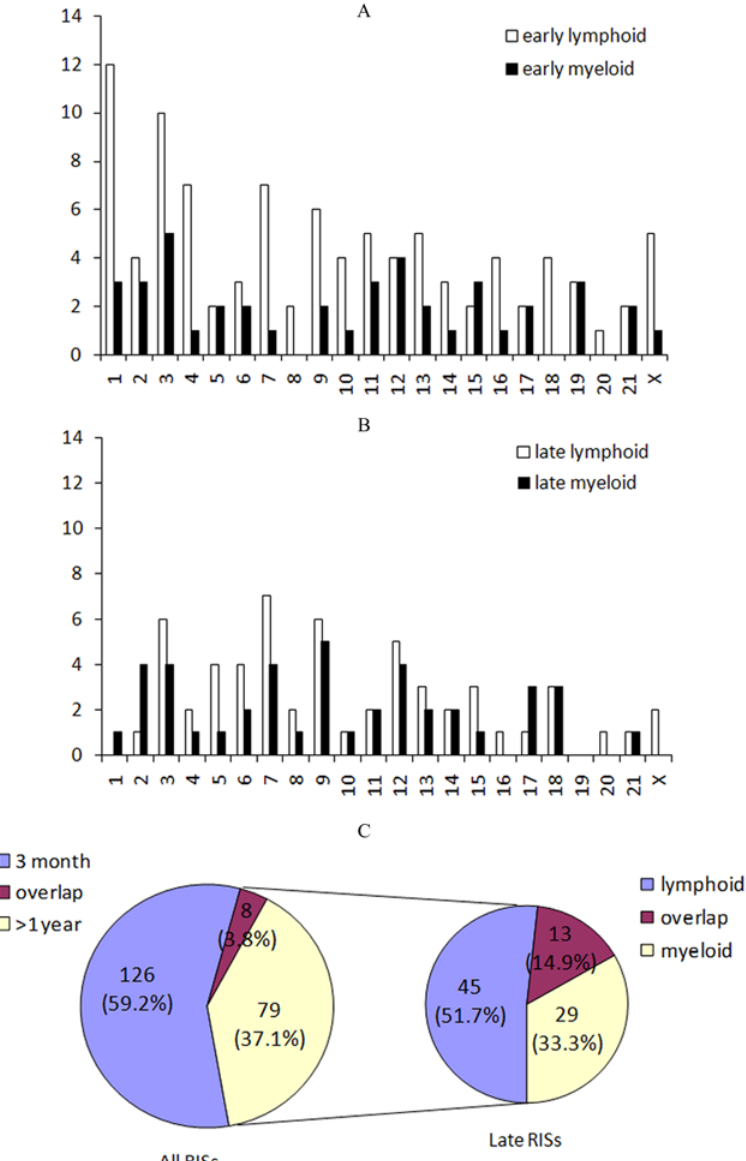
Figure 2. Distribution of RISs. 2A shows the RISs from the samples up to 3 months post transplant (early); 2B contains samples over 1 year post transplant (late). Lymphoid (white bars) and myeloid (black bars) are distinct each other. X-axis refers to the chromosome number; Y-axis, the number of RIS. 2C depicts the overlap of RIS between early stage and late stage. Among all RISs, there were only 8 of 213 overlapping between early and late samples, equivalent to 3.76%. Only 13 of 87 RISs were overlapping between lymphoid and myeloid from the late samples, equivalent to 14.9%.